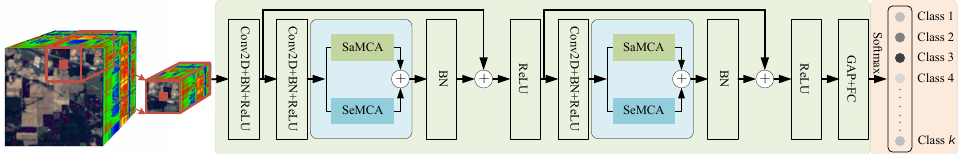
Figure 2. The overall architecture of the proposed DMuCA network, where SaMCA and SeMCA are plugged parallel into a ResNet with two residual